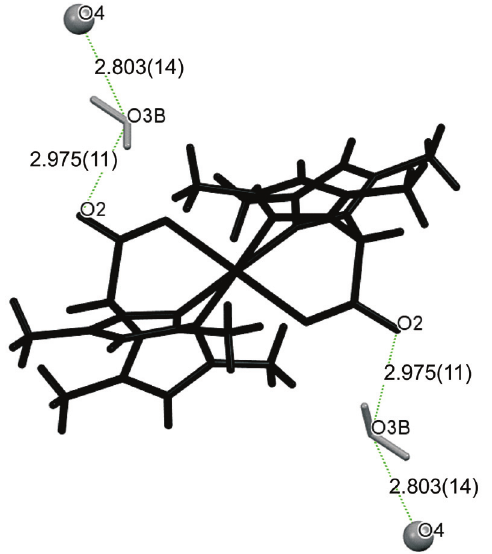
Figure 5. Hydrogen bonding in 4 , considering the presence of O3b site (occupancy ∼ 20%). Two pairs of water molecules are hydrogen bonded to the isolated coordination